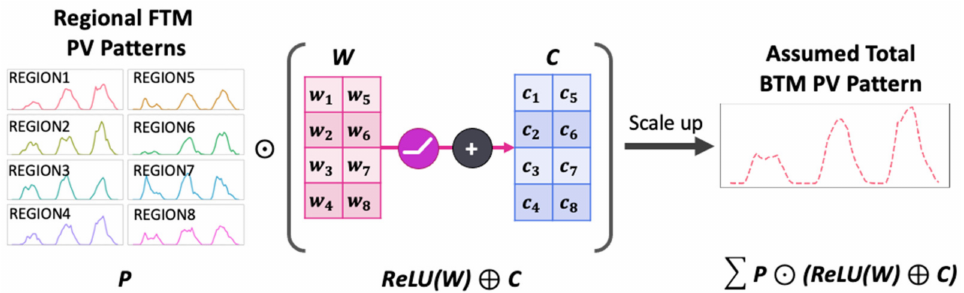
Figure 9. Illustrated BTM PV estimation procedure in Figure